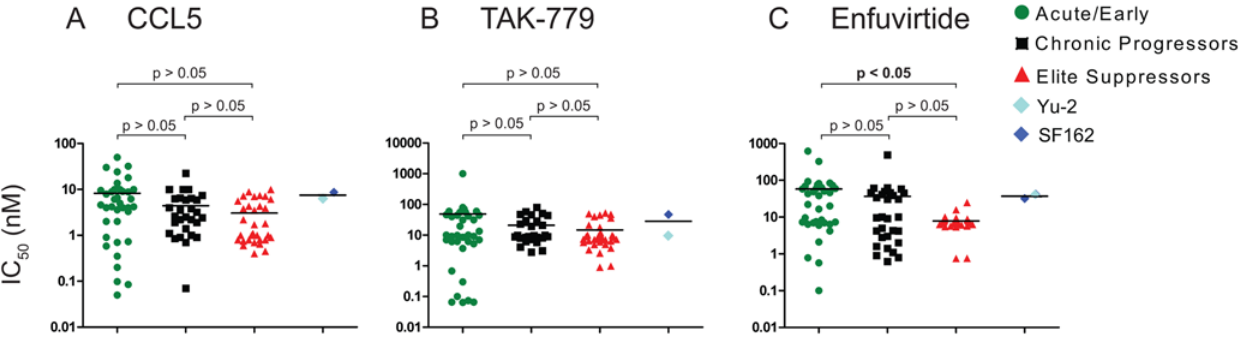
Figure 5. ES, CP, and acute clones show no differential susceptibility to CCL5, TAK-779, or ENF. (A–C) ES, acute, and chronic clones were used to infect Affinofile cells induced to express approximately 125,000 molecules CD4 and approximately 1,274 molecules CCR5/cell. (A) CCL5 was added in concentrations ranging from 0.1–50 nM, incubated for 1 h, and infected. Plots represent percent replication relative to no drug. 50 percent inhibitory concentrations of drug (IC 50 values) were computed from the curves and plotted for acute, chronic, ES, and Yu-2 or SF162 envelopes. (B) TAK-779 was added to the induced Affinofile cells at concentrations ranging from 0.1 nM–1 m M. Plots were used to determine IC 50 values for each envelope. (C) Enfuvirtide was added to cells at concentrations ranging from 0.1 nM–1 m